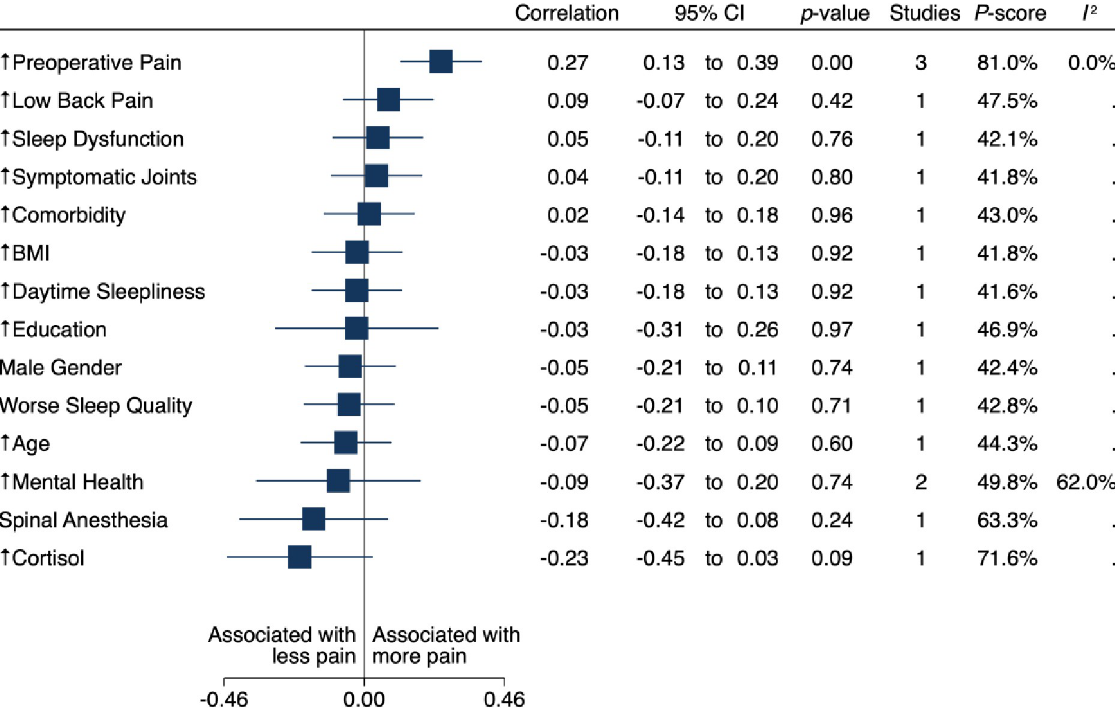
Fig 4. Forest plot of factors associated with pain at three